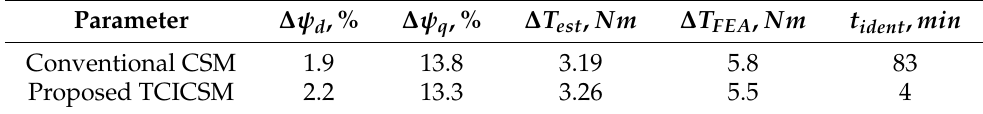
Table 2. Comparison of considered methods (maximum difference